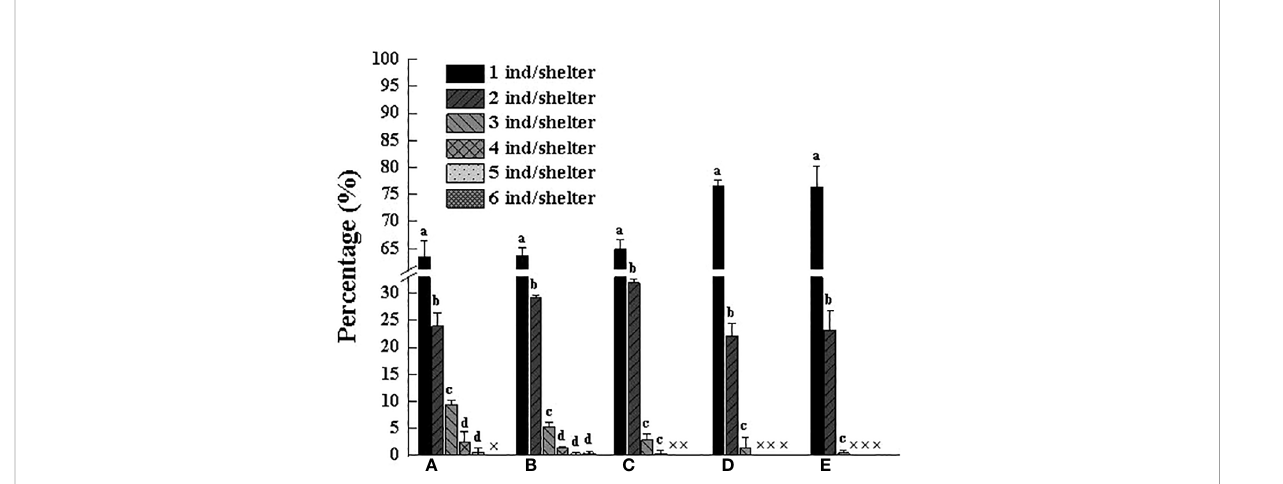
FIGURE 4 The percentage of the number of swimming crabs in each body weight group in the same shelter at the same time to the total number of the group. Different letters indicate signi fi cant differences among different numbers of swimming crab under the same shelter ( P <